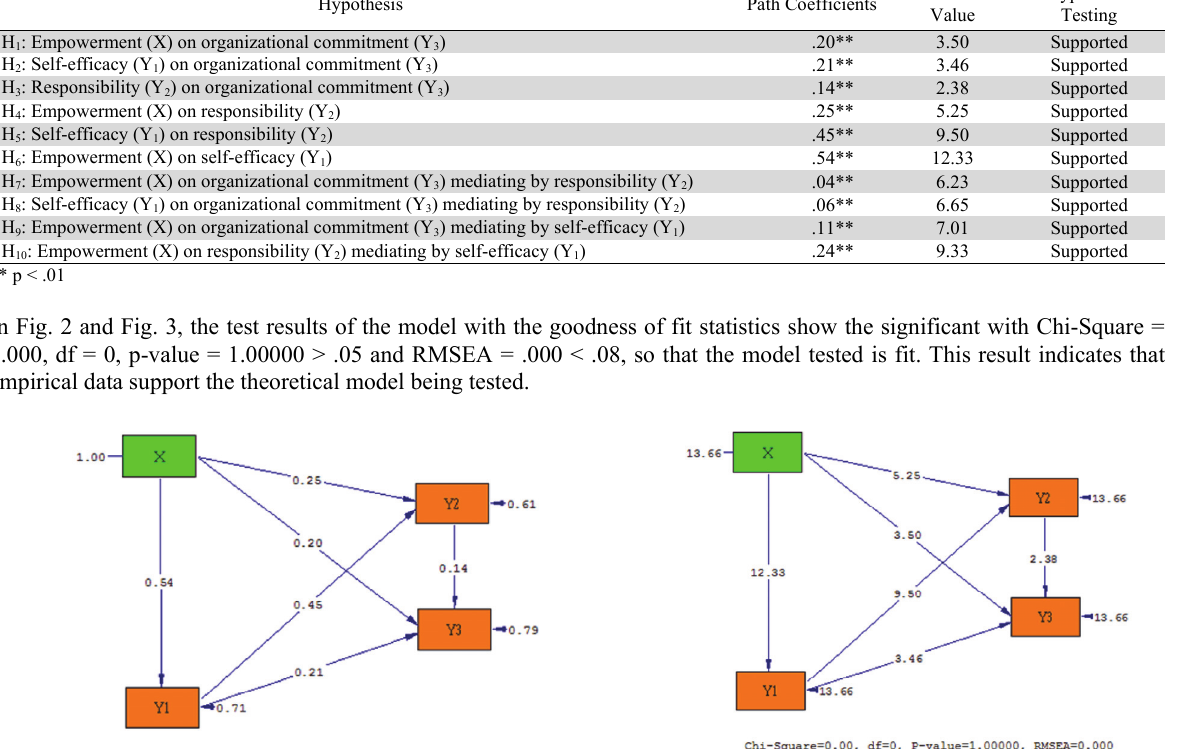
Summary of path coefficients and t-values Hypothesis Path